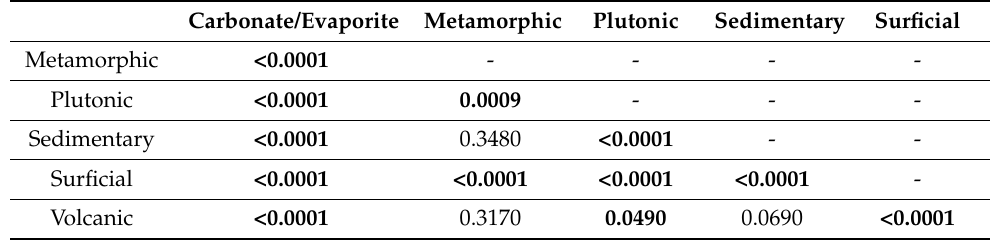
Table 2. P -values from pairwise comparison of aluminum concentrations with groundwater regions. Values significant at the 5% significance level are bolded. Table 2. P-values from pairwise comparison of aluminum concentrations with groundwater re- gions. Values significant at the 5% significance level are bolded.